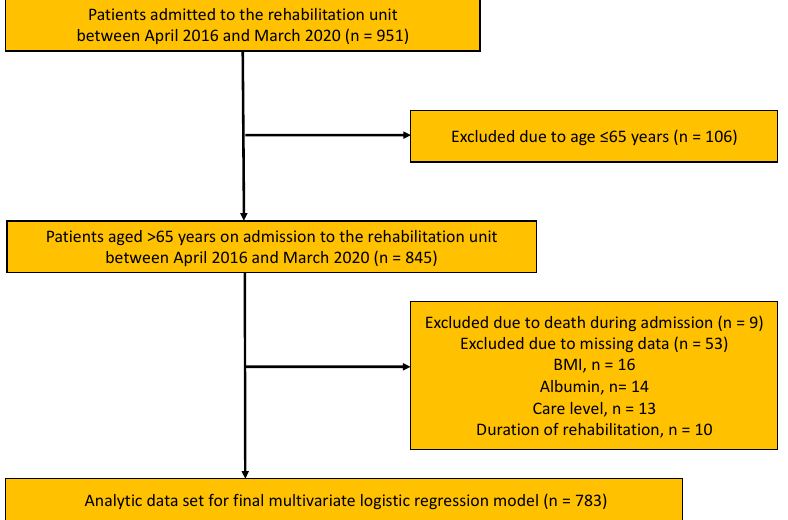
Figure 1. Flowchart of the participant selection. BMI, body mass index.